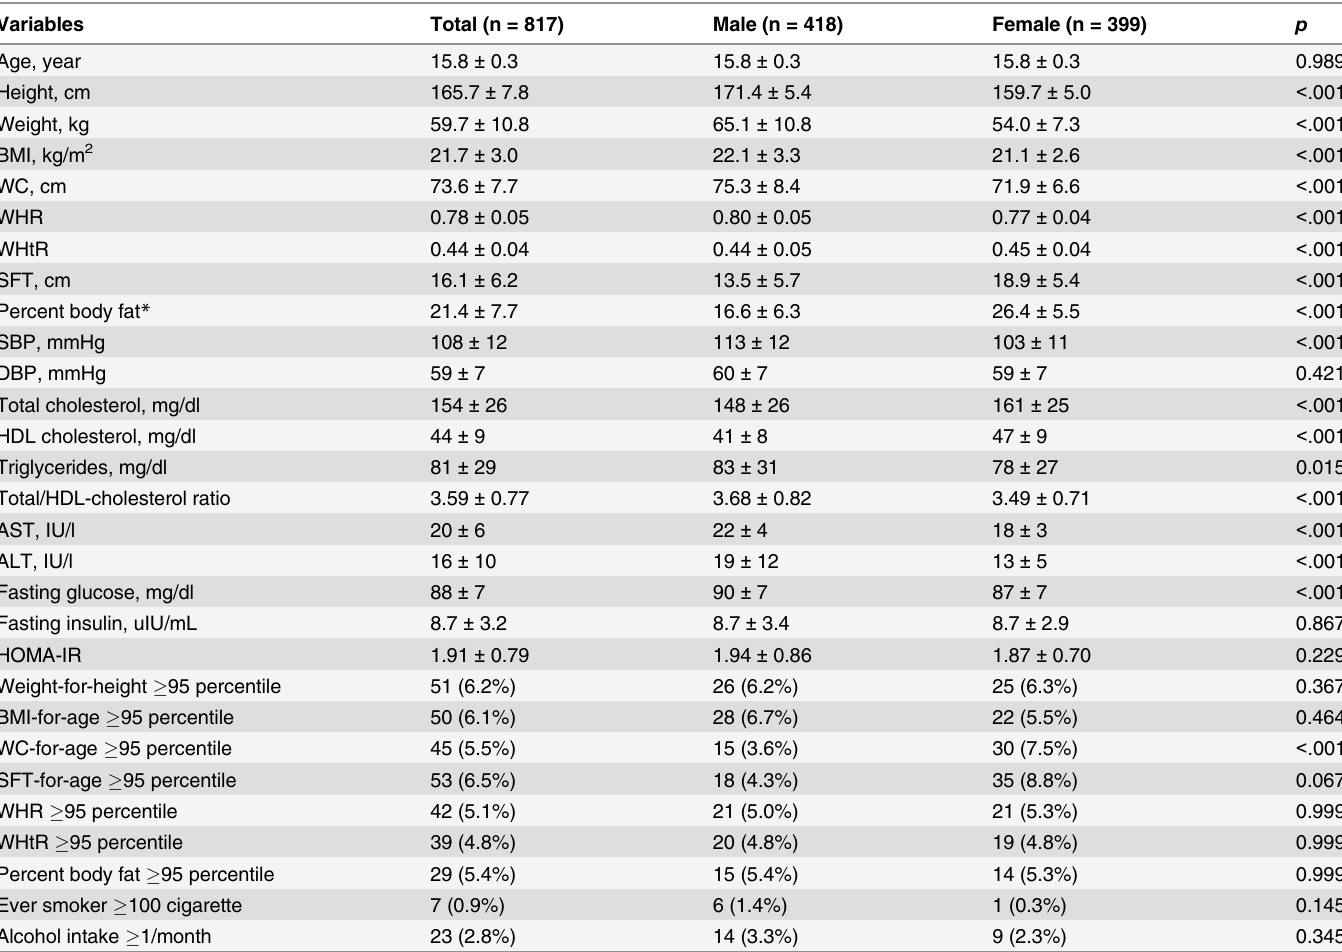
Table 1. Characteristics of Study